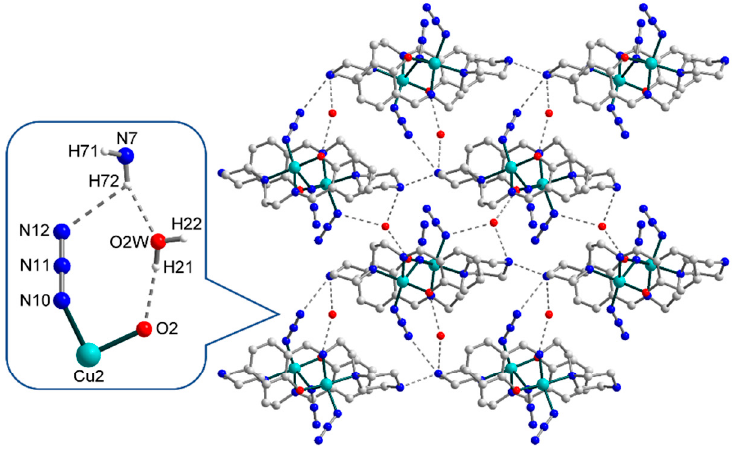
Figure 3. Representation of the supramolecular layer in 1 , viewed down the crystallographic b axis, with the enlarged fragment showing the supramolecular synthon formed by H-bonding between Schi ff base ligands, terminal azide group, and uncoordinated water molecule. The hydrogen atoms are omitted for clarity. Colour scheme: Cu, cyan; O, red; N, blue; C,